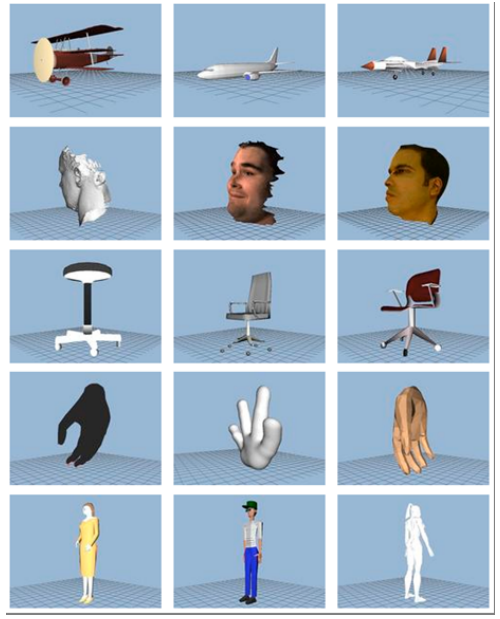
Figure 2. Examples of the 3D objects, belonging to five var- ious classes, from the Princeton Shape Benchmark database [14] used in the experiment.